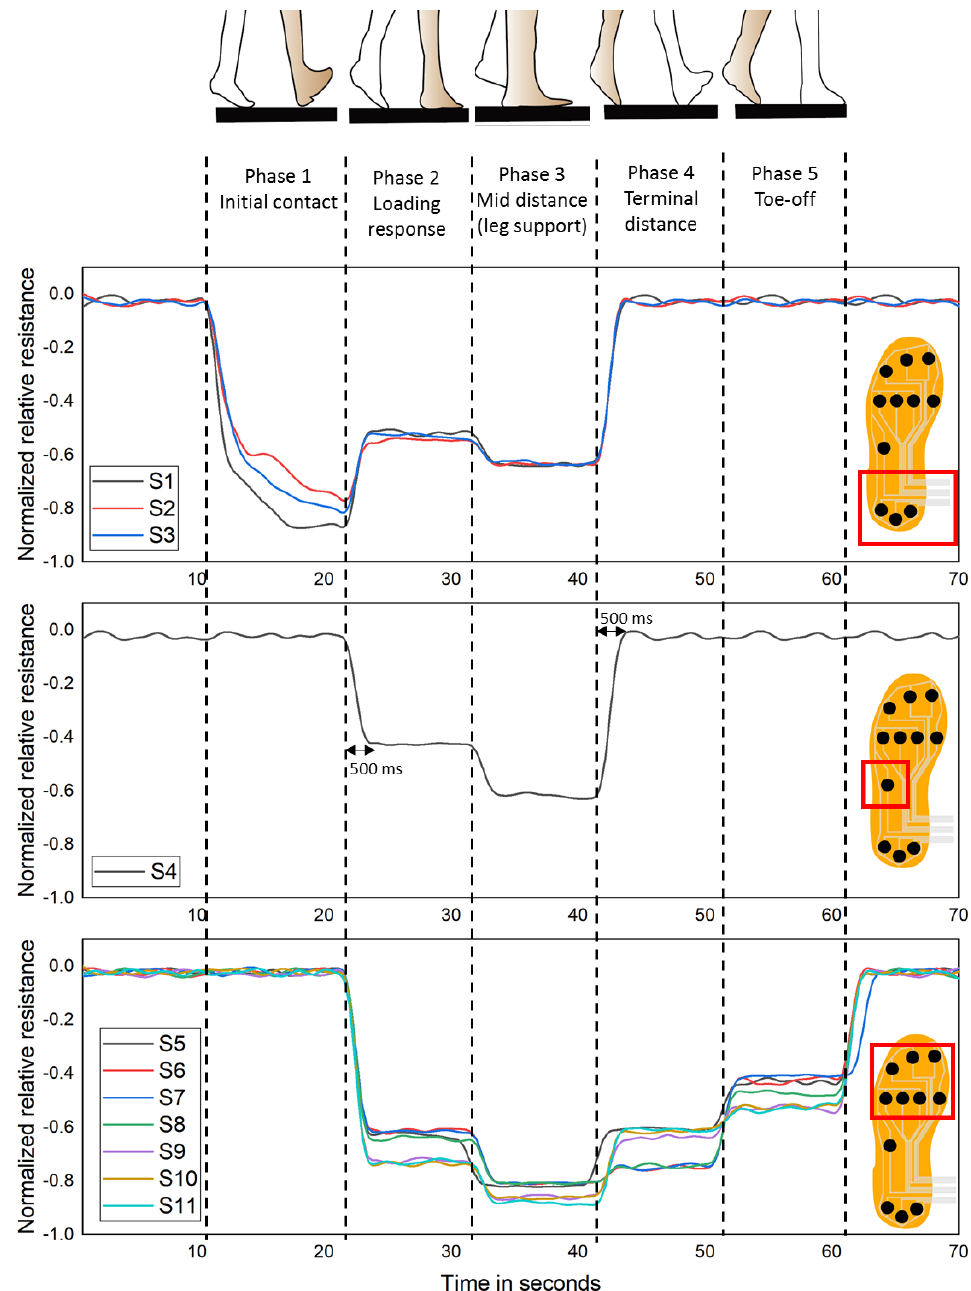
Figure 16. Dynamic response of the pressure sensor during dynamic phase. When the swinging leg reaches the mid-distance position, the respective foot is sub- jected to less pressure because the bodyweight is transferred from the supporting foot while it is not in contact with the ground. This makes the slight increase in the normal- ized resistance of the sensors S1–S11 by 20–30%. In the terminal distance, the heel of the supporting foot and forefoot of the swinging foot contacts the ground, and the pressure is applied on the forefoot (S5–S11). Even though the pressure is applied on the forefoot of the swinging leg, the bodyweight is more transferred to the supporting leg. So the pressure distributed on the forefoot reduced compared to the previous position. In toe-off, only the forefoot in contact with the ground and sensors S5–S11 is subjected to pressure,